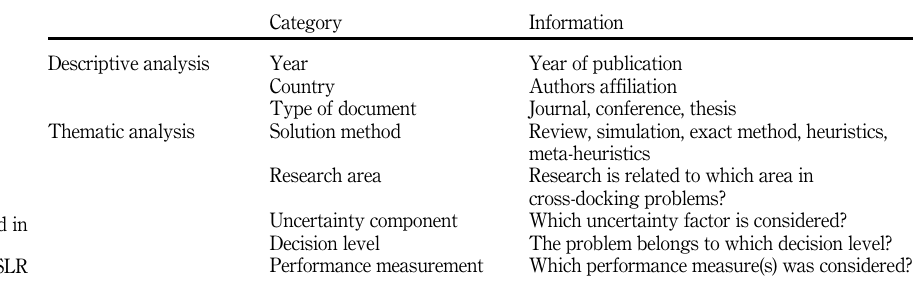
Table I. Classifications used in categorising and analysing data in